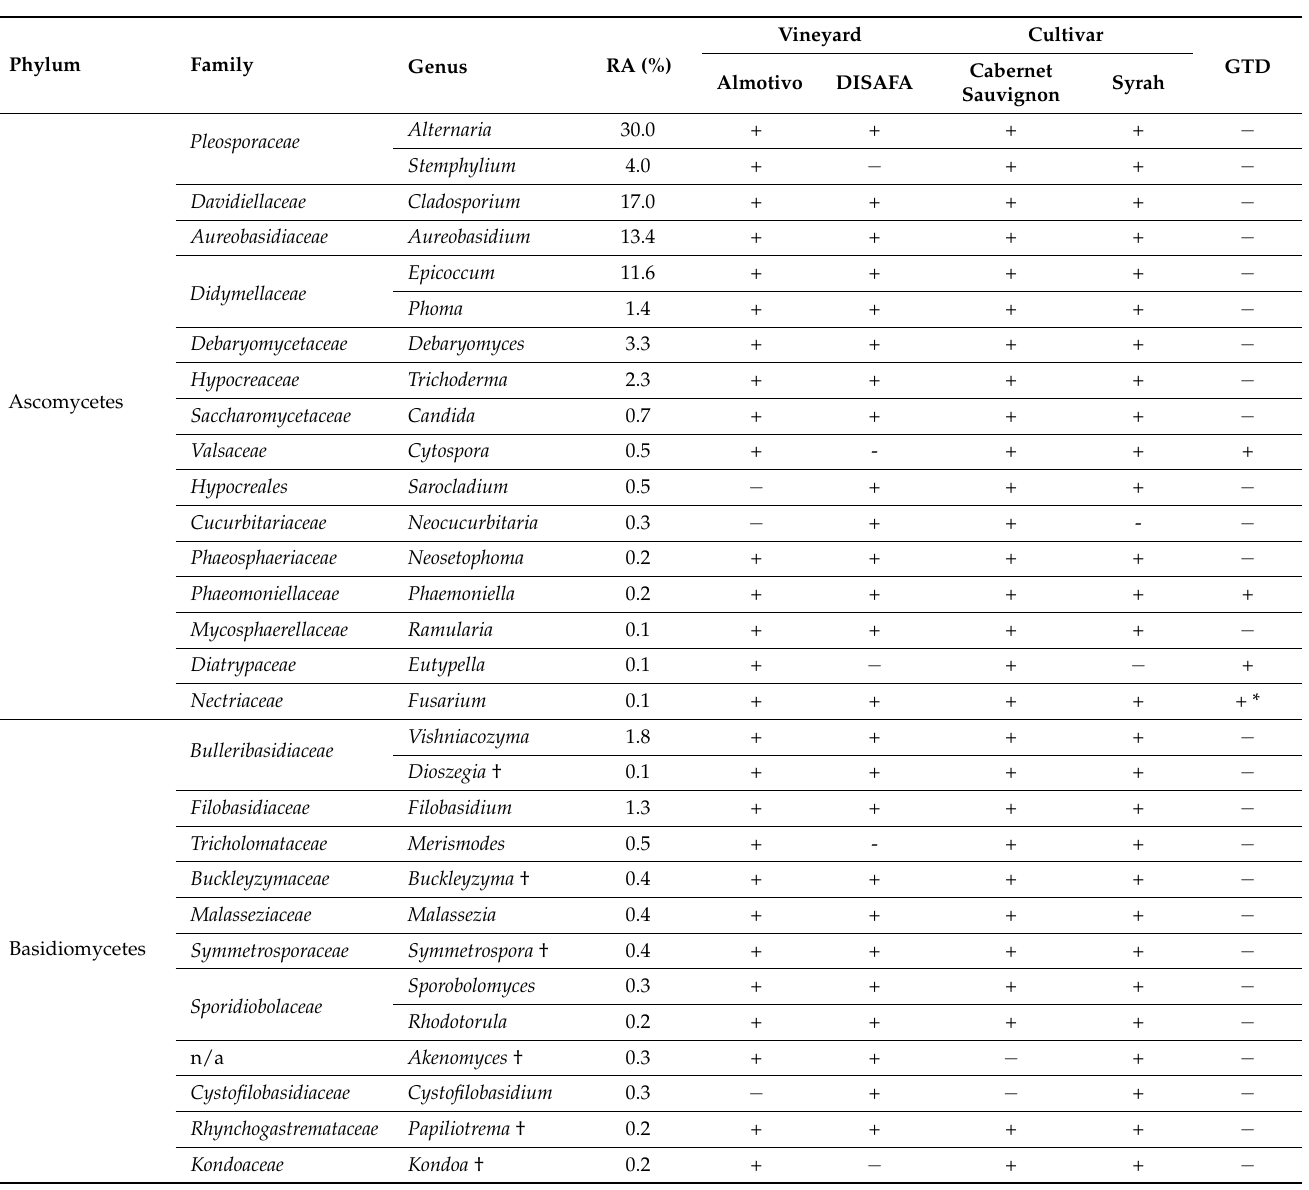
Table 2. Taxonomic classification of the 30 most abundant taxa identified at the genus level and found at a relative abundance (RA) equal to or greater than 0.1% of the total dataset. Presence (+) or absence ( − ) of individual taxa is displayed when comparing vineyards (Almotivo, DISAFA) and cultivars (Cabernet Sauvignon, Syrah) and when examining GTD-associated fungi